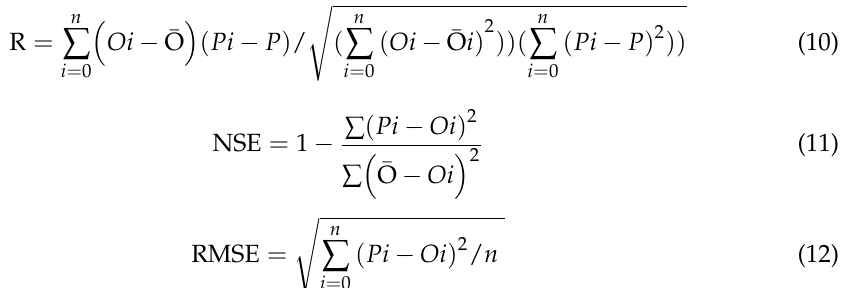
Figure 3. Flowchart of the adopted methodology.